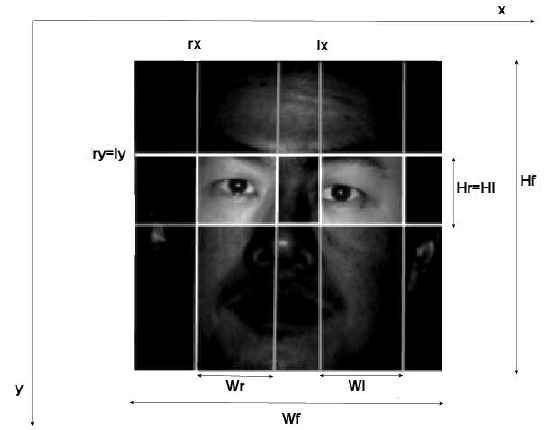
Figure 4. The rough localization of the eye regions. Labels are explained in the text.